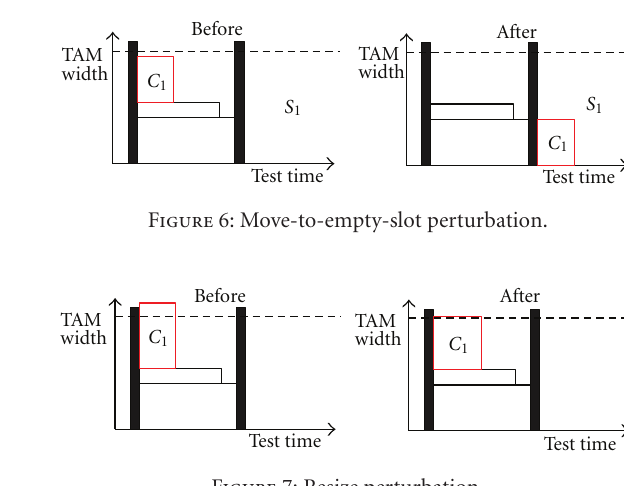
Figure 5: Move-to-existing-slot perturbation.